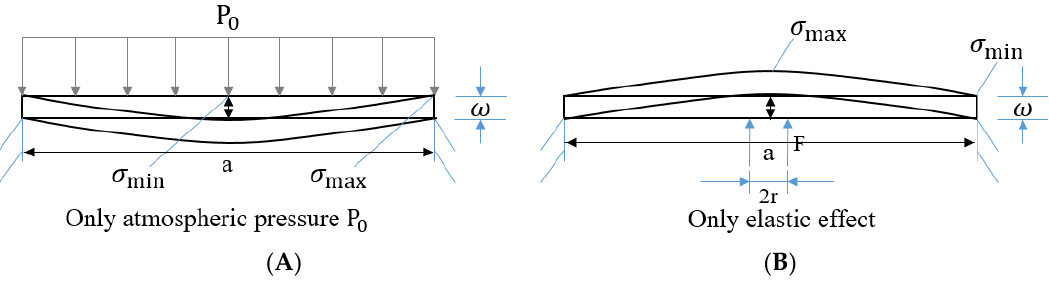
Figure 3. Schematic of the calculation model. ( A ) only atmospheric pressure P 0 ; ( B ) only elastic effect.